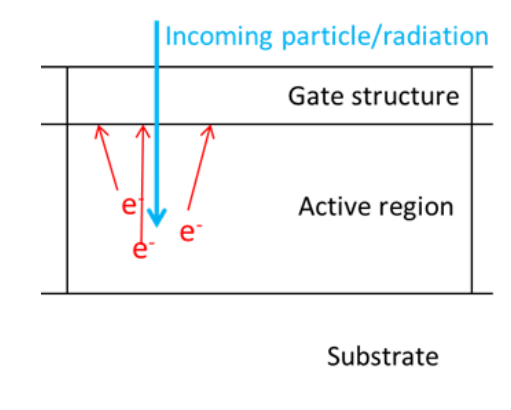
Fig. 1. A schematic cross section of a single pixel within a CCD.